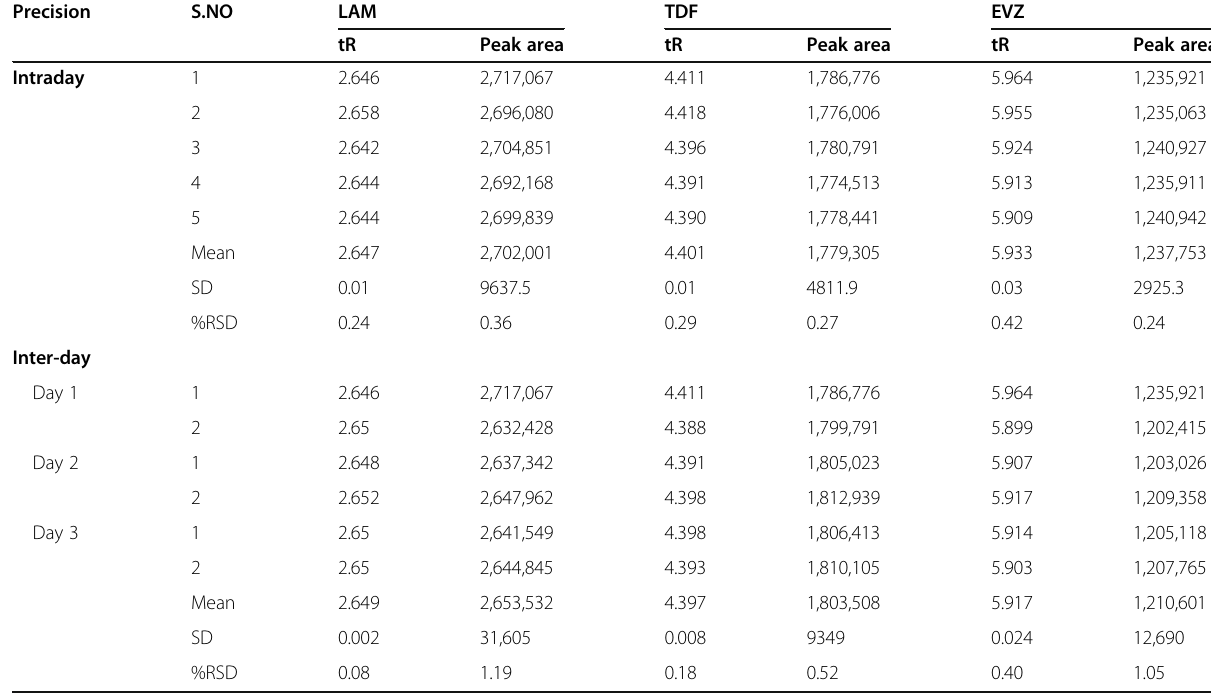
Table 5 Results of intraday and inter-day precision of standard solution Precision